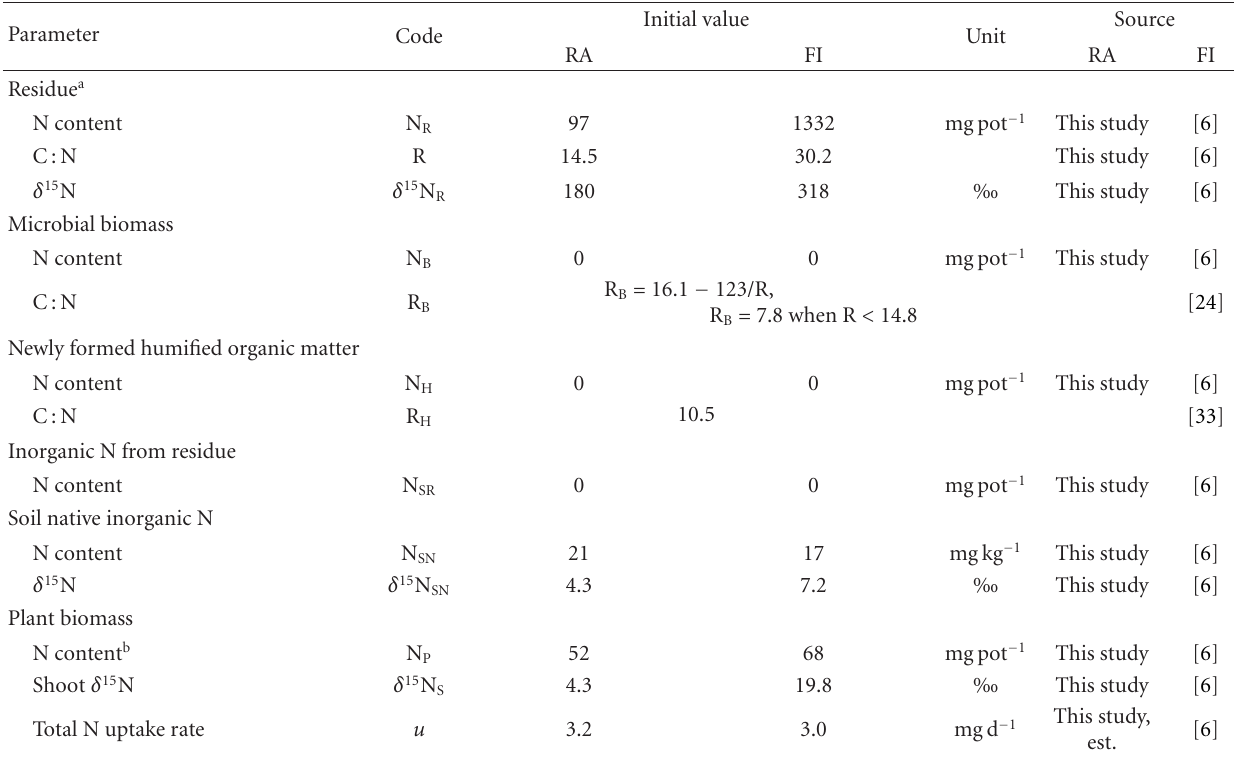
Figure 1: Model of residue decomposition and subsequent uptake of residue N by a recipient plant. Each pool is divided into 14 N and 15 N. Subscripts R1 and R2, B1 and B2, and H1 and H2 refer to the pools related to the two residue fractions in the residue, microbial biomass, and humified organic matter, respectively. Parameters k and λ are decomposition rate constants for residue and microbial biomass, respectively, Y is assimilation yield of C from residue by microbial biomass, and h is humification rate of microbial biomass. Parameter u is N uptake rate by the recipient plant, and its subscripts SR and SN refer to the uptake rates from the two soil inorganic pools (Table 2). Parameter Sf is N source factor which determines the relative N uptake rates from the two soil N pools. Parameter m SO is mineralisation rate for soil organic N. Pools and processes indicated with bold lines are simulated according to Nicolardot et al. [24]. Table 1: Parameters of the residue decomposition model for the residue application (RA) and full interaction (FI) experiments. Where δ 15 N is not given, it is defined by δ 15 N of the source